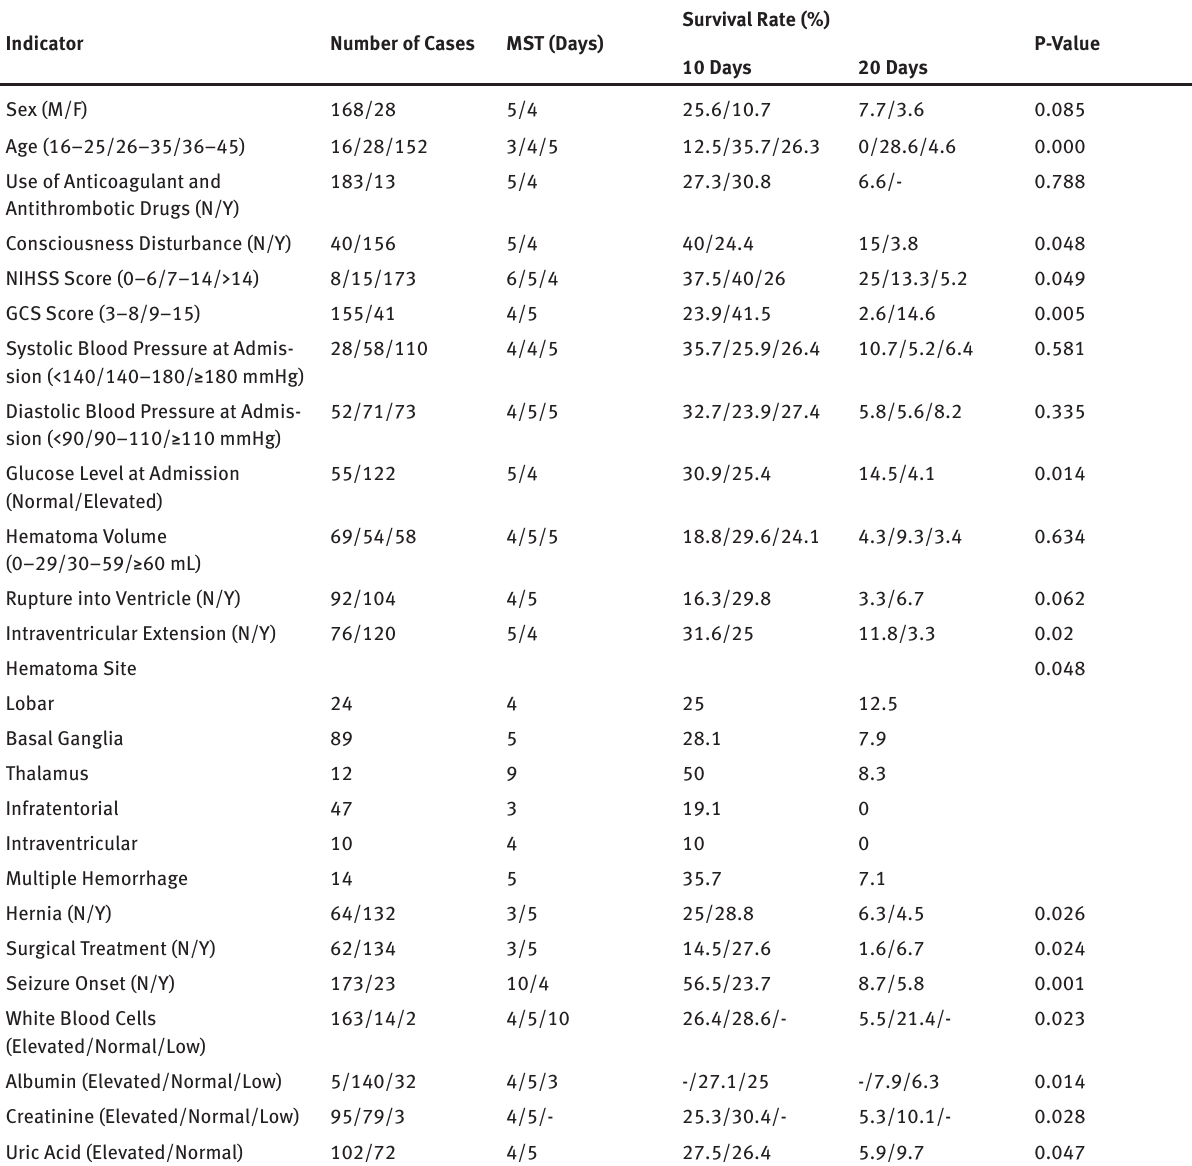
Table 1: Univariate analysis of factors influencing survival in 196 young adult patients with ICH